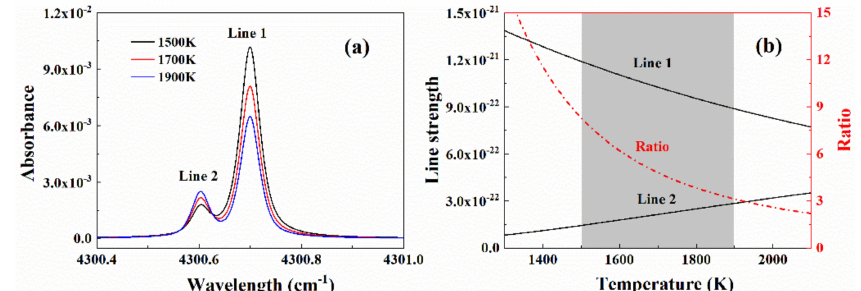
Figure 12. ( a ) Spectral simulation of the selected line pair of CO. ( b ) Line strengths and the ratio of selected line pair versus temperature. The simulation conditions are P = 1 atm, L = 11.56 cm, and 1.0% CO.